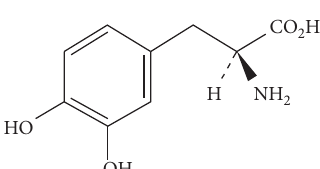
Figure 1: Chemical structure of